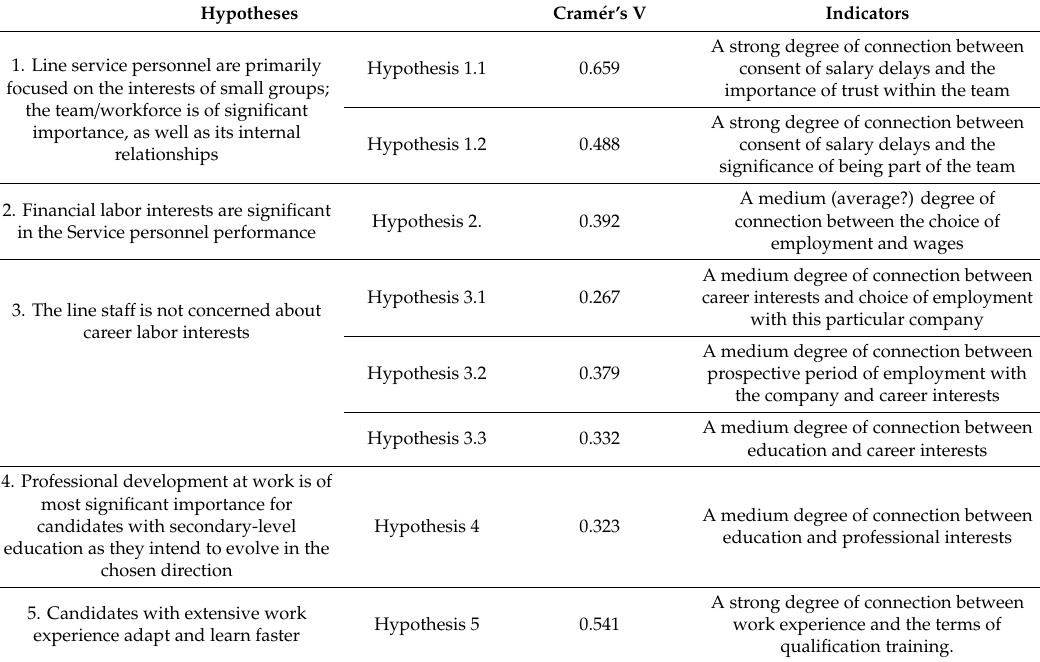
Table 2. Summary table reflecting the level of communication